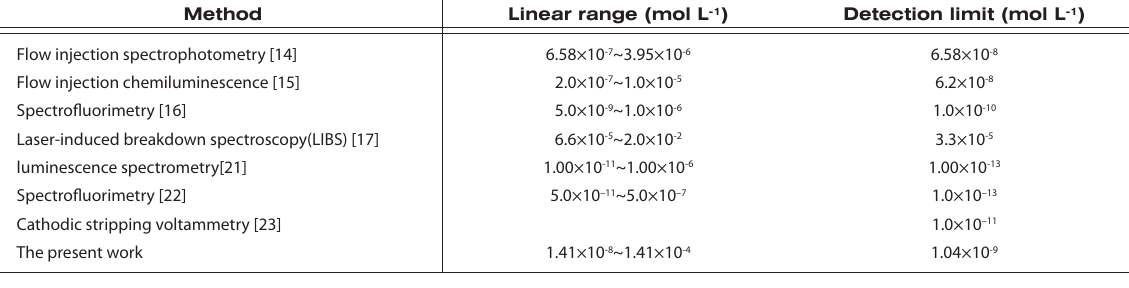
Table 4. A comparison of the proposed method with other methods for determining Eu 3+